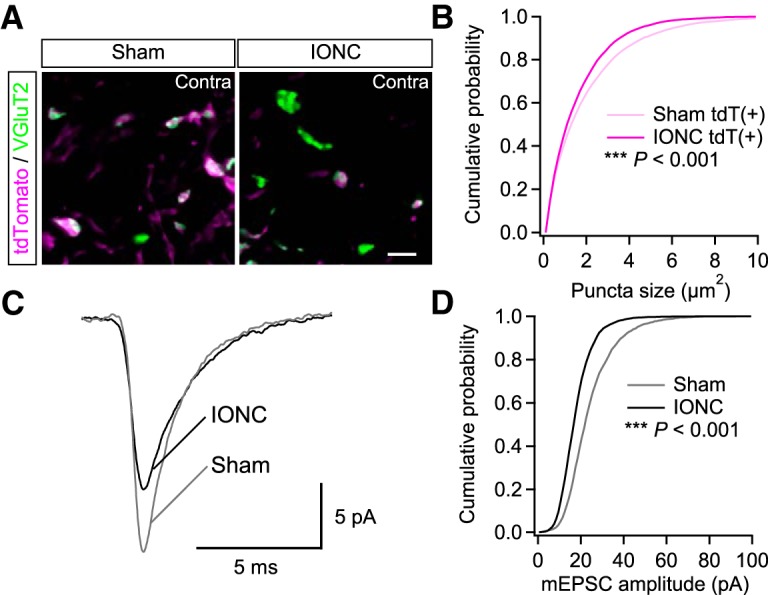
IONC decreased size of PrV2-origin lemniscal fiber terminals in V2 VPM and amplitude of lemniscal fiber-derived miniature EPSCs. A, VGluT2-immunostained V2 VPM sections of Krox20-Ai14 mice. Scale bar, 5 µm. B, Cumulative probabilities of tdT-positive VGluT2 puncta in the V2 VPM after sham and IONC operations. Nine mice (eight images from each mouse) were analyzed for each group. C, Averaged traces of asynchronously released miniature EPSCs from a lemniscal fiber in the VPM. Traces of 1517 and 2356 events from 12 and 15 neurons of sham- and IONC-operated mice, respectively. D, Cumulative probabilities of lemniscal fiber-derived miniature EPSC amplitude. Statistical significance was tested by two-sample Kolmogorov-Smirnov test (B and D). ***p < 0.001; two-tailed.